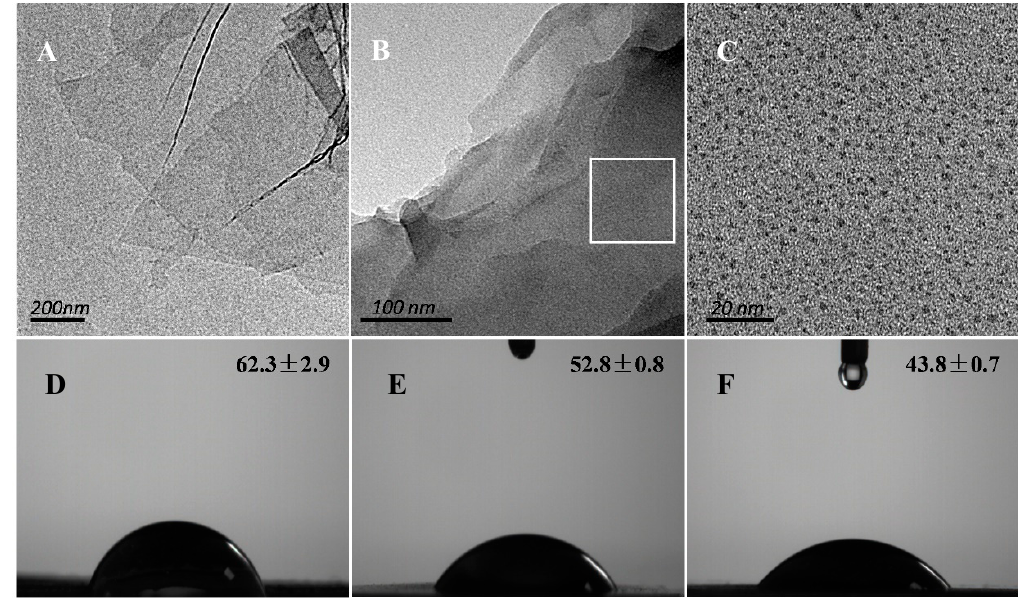
Figure 1. TEM images of graphene oxide (GO) ( A ) and tetracycline hydrochloride (TC)/polyethyleneimine (PEI)-functionalized GO (PG) ( B , C ). C shows a higher magnification of the square location in image B. Contact angle pictures of GO ( D ), PG ( E ), and TC/PG ( F ).